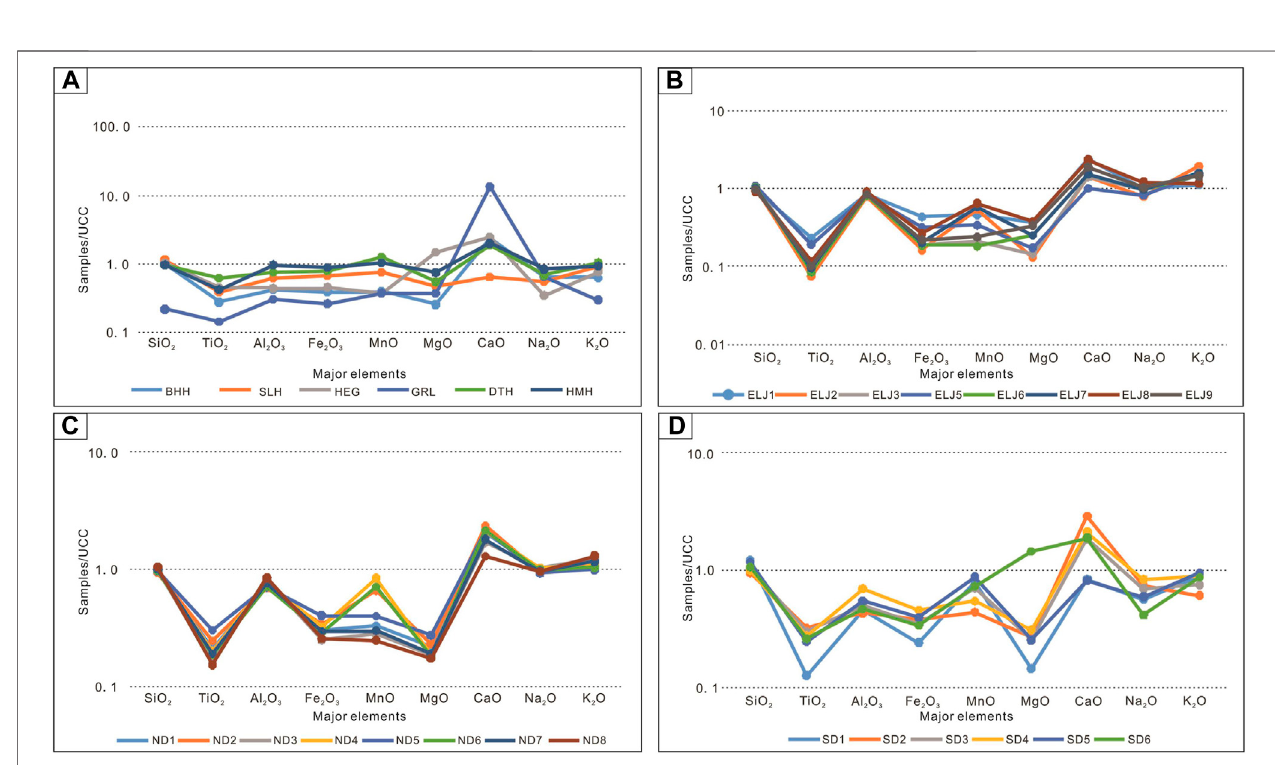
FIGURE 5 | UCC-normalized spider diagrams ofmajor elements for different samples from the Qinghai Lake area. (A) Samples from rivers and GRL foreshore, (B) samples from Erlangjian beach bar (ELJ), (C) samples from Niaodao beach (ND), and (D) samples from aeolian sand dune (SD), respectively.